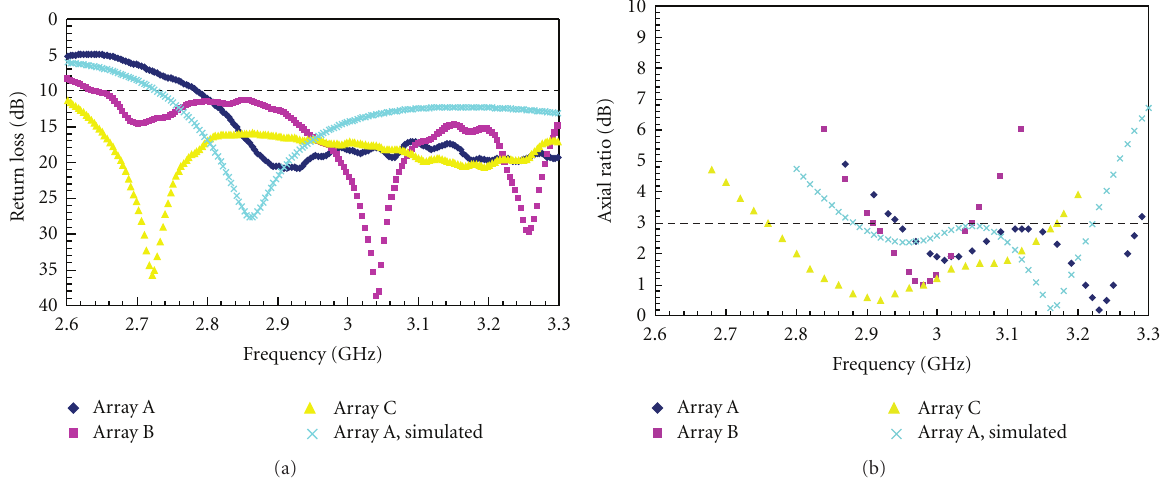
Figure 4: Measured results for the three array prototypes; d = 73 mm. (a) Return loss. (b) Axial ratio.